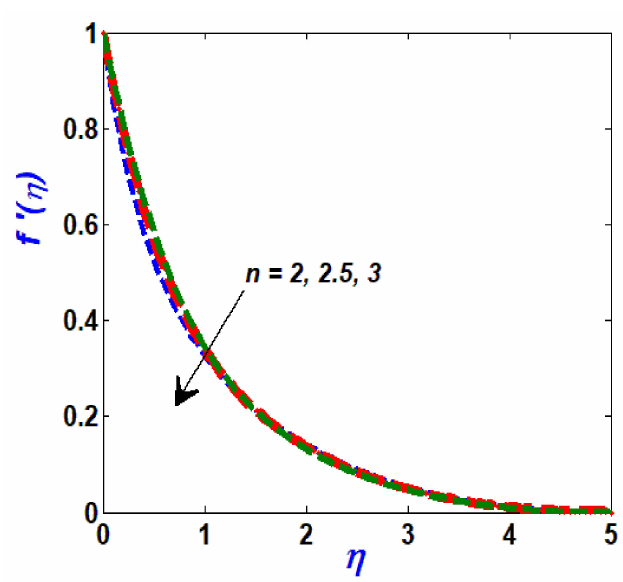
Figure 3. Velocity & acceleration profiles with variation in n